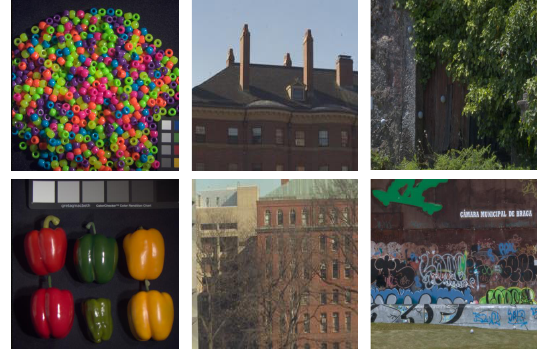
Figure 6. Some RGB images corresponding to hyperspectral images on three